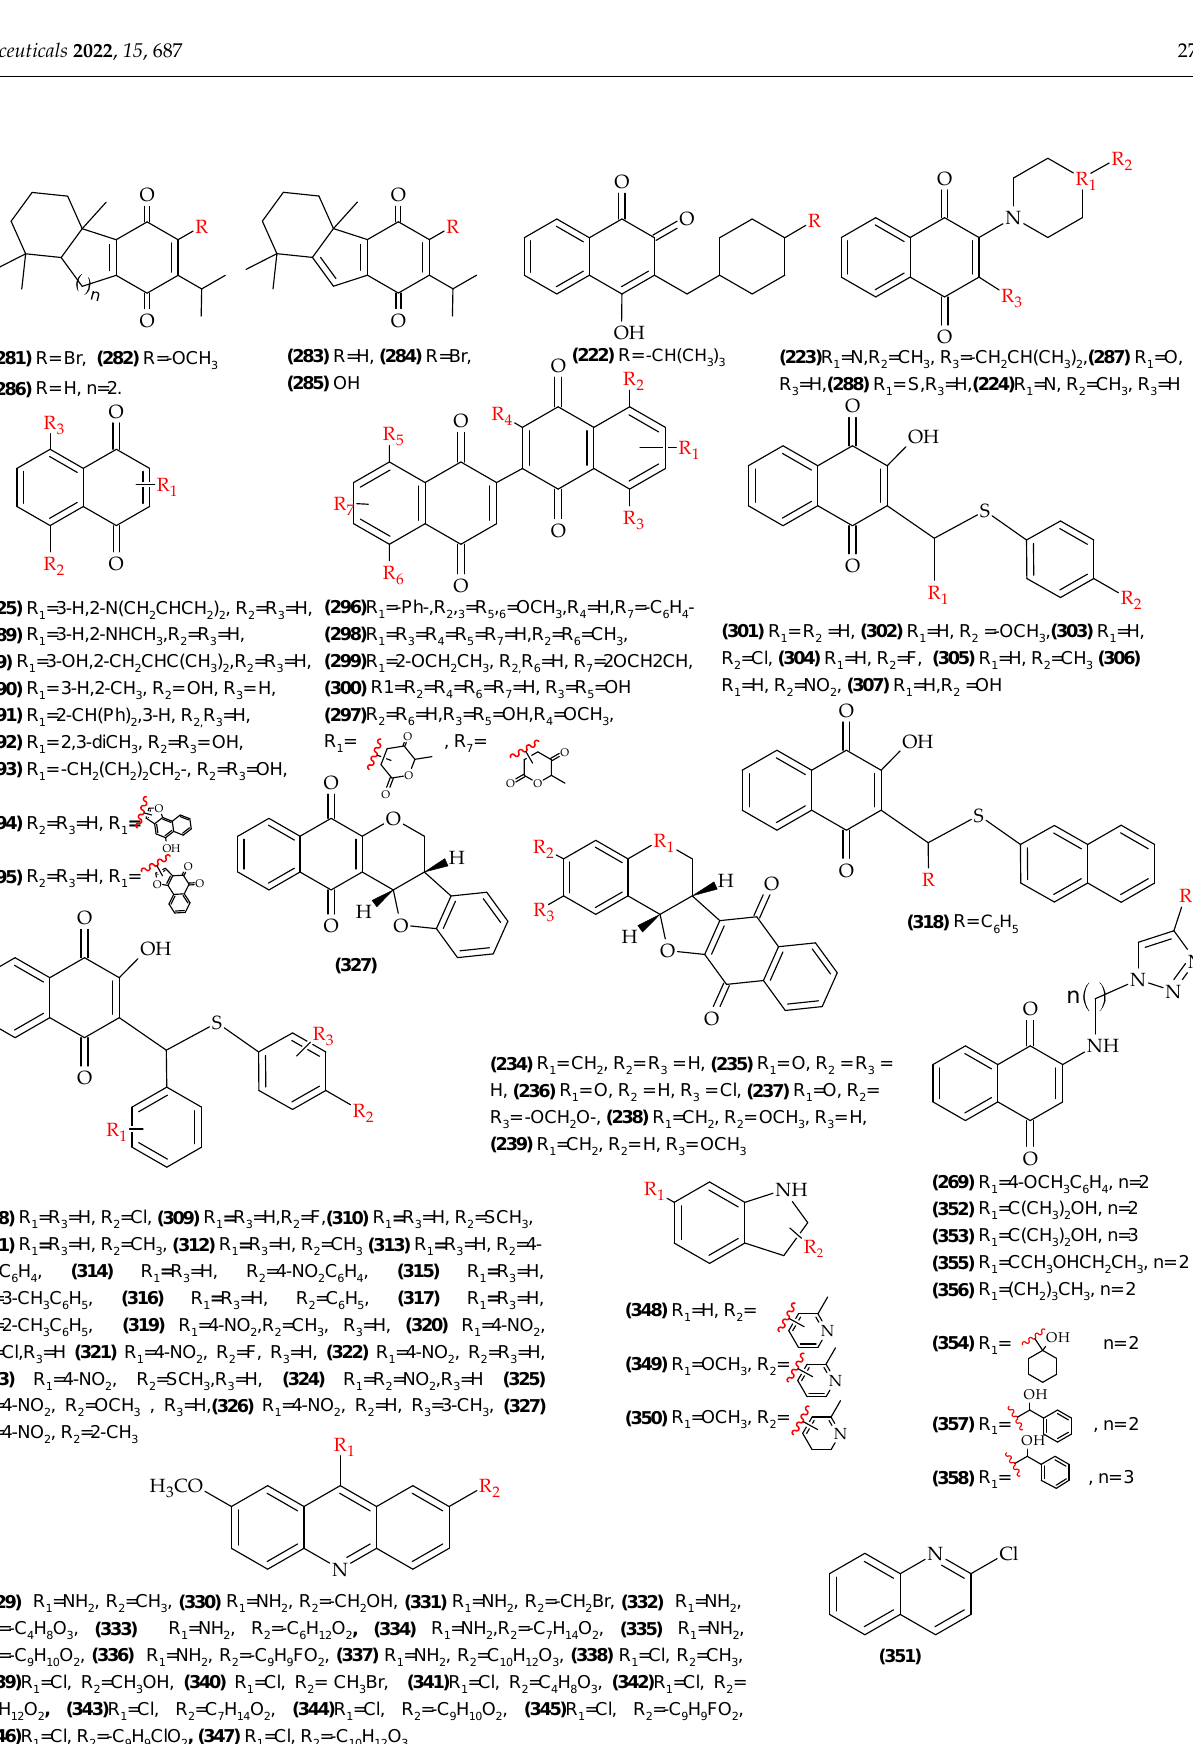
Figure A3. Molecules with reported biological activity used for the development of the anti-L. infantum QSAR model.